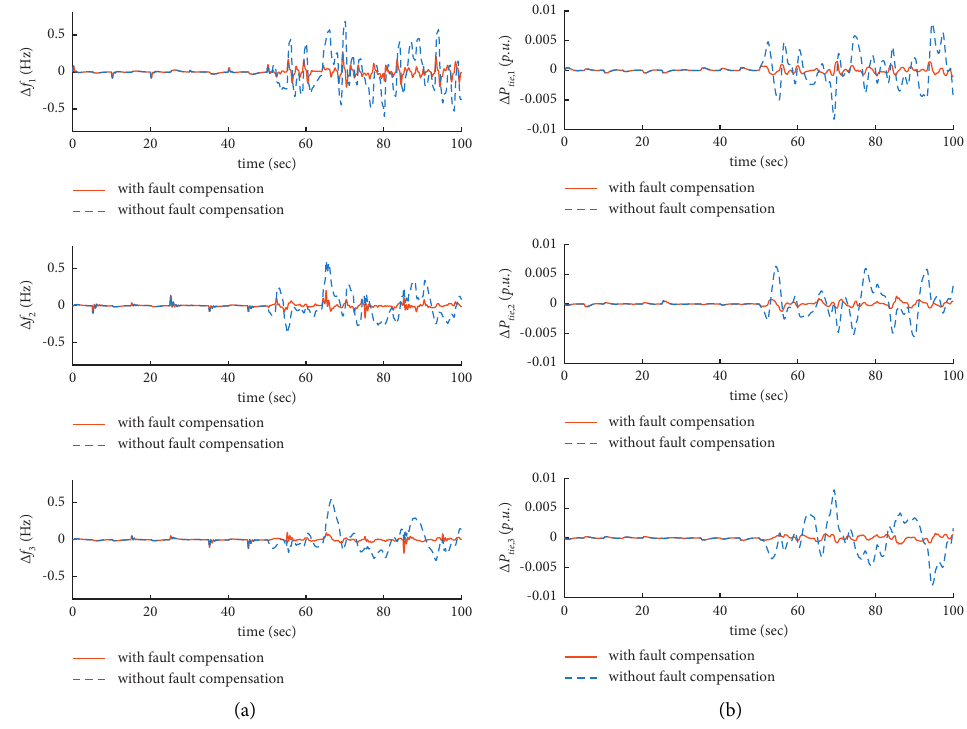
Figure 5: Simulation performance. (a) Δ f D i